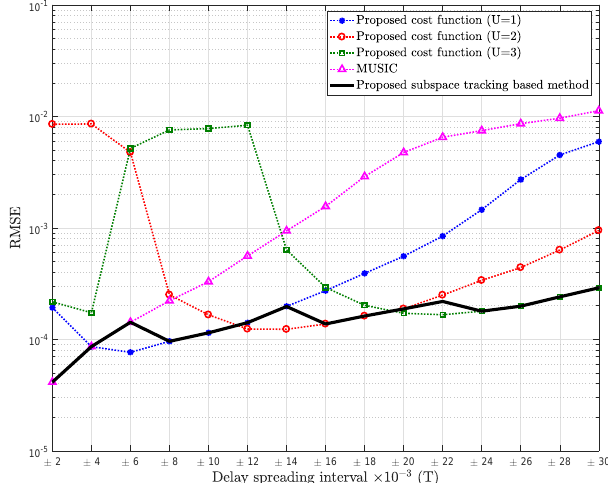
Figure 4. RMSE of mean delay estimation vs. delay spreading of the proposed cost function for U = 1, U = 2 and U = 3, the proposed subspace tracking based method, and MUSIC; P l = 20, K = 64, SNR = 5